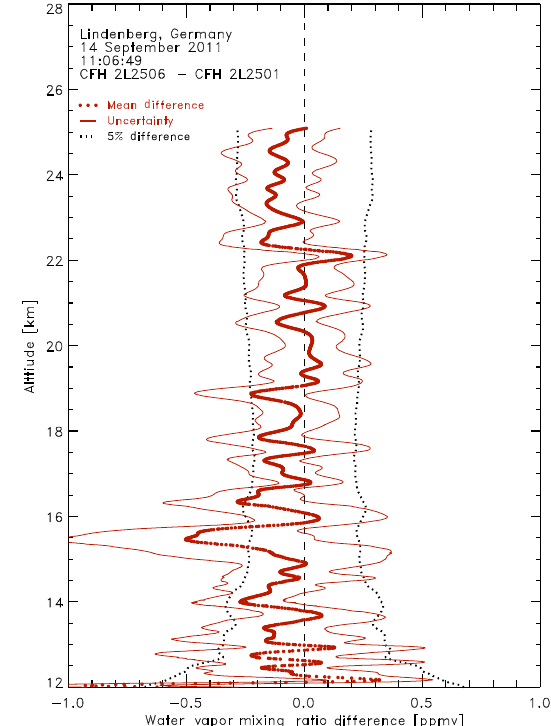
Figure 4. Absolute mixing ratio difference of the two simultaneous profiles shown in Fig. 3. Also shown is the combined uncertainty. To provide a guide for the relative difference, a 5% difference in mixing ratio is indicated by thin dotted